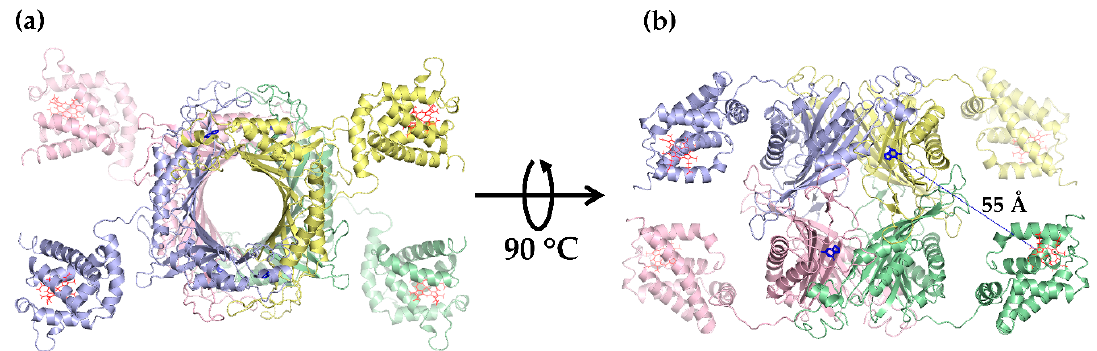
Figure 3. Tetrameric structure of CUOX-VHb fusion protein constructed by assembly of 3D structure of CUOX-VHb predicted by I-TASSER. One color represents one fusion protein chain. Heme prosthetic groups in VHb active sites are represented by red sticks while 5-amino 6-nitro uracil molecules sitting in uricase active sites are represented by blue sticks. ( a ) Top view of the tetramer. ( b ) Side view of the tetramer. The distance between the adjacent CUOX and VHb active sites is 55 Å.